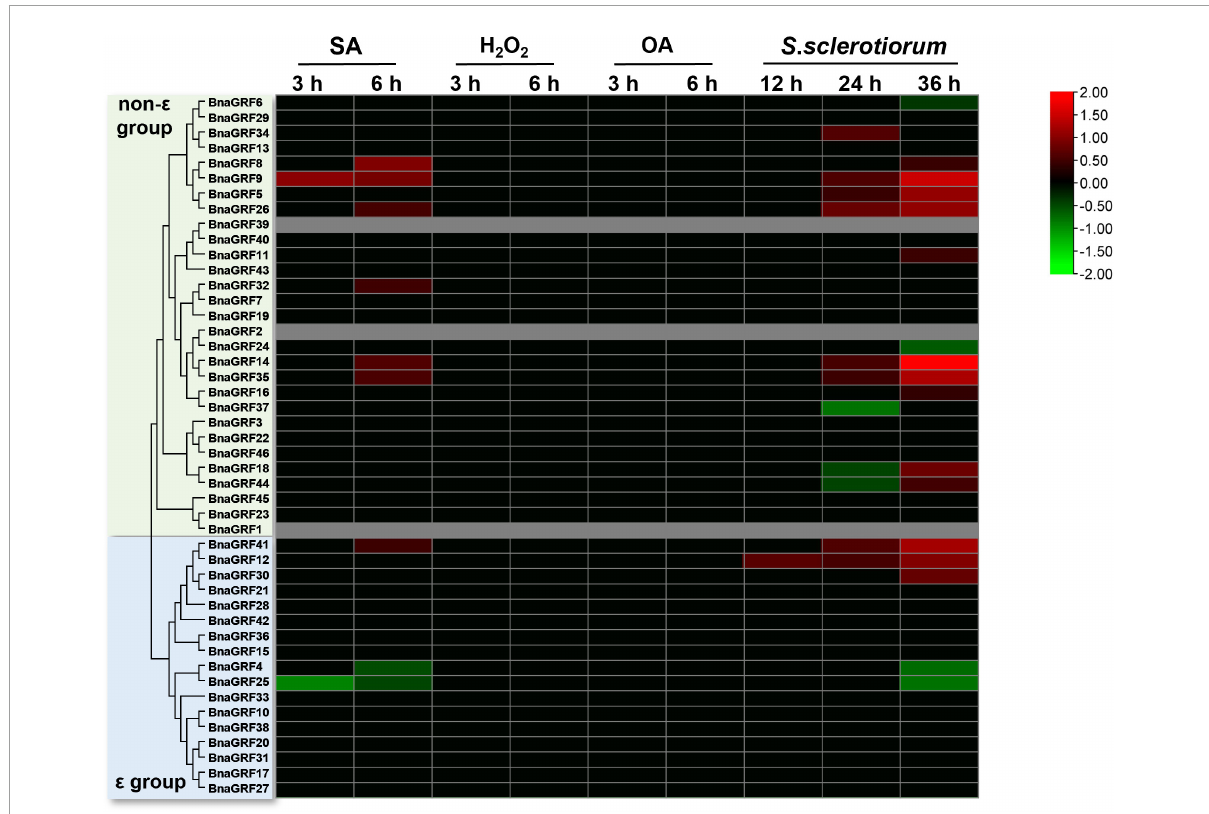
FIGURE7 Relative expression levels of BnaGRFs under salicylic acid (SA), hydrogen peroxide (H 2 O 2 ), and oxalic acid (OA) treatments and Sclerotinia sclerotiorum inoculation. No significant change in expression ( p > 0.01) is shown as 0. Red and green colors indicate significantly up- and downregulated genes, respectively, and gray color represents no expression data. The heatmap was constructed by taking Log2 values of the transcript per million fragments mapped (FPKM) generated from RNA-seq data. The bars of BnaGRFs on heatmap represent the expression change folds after